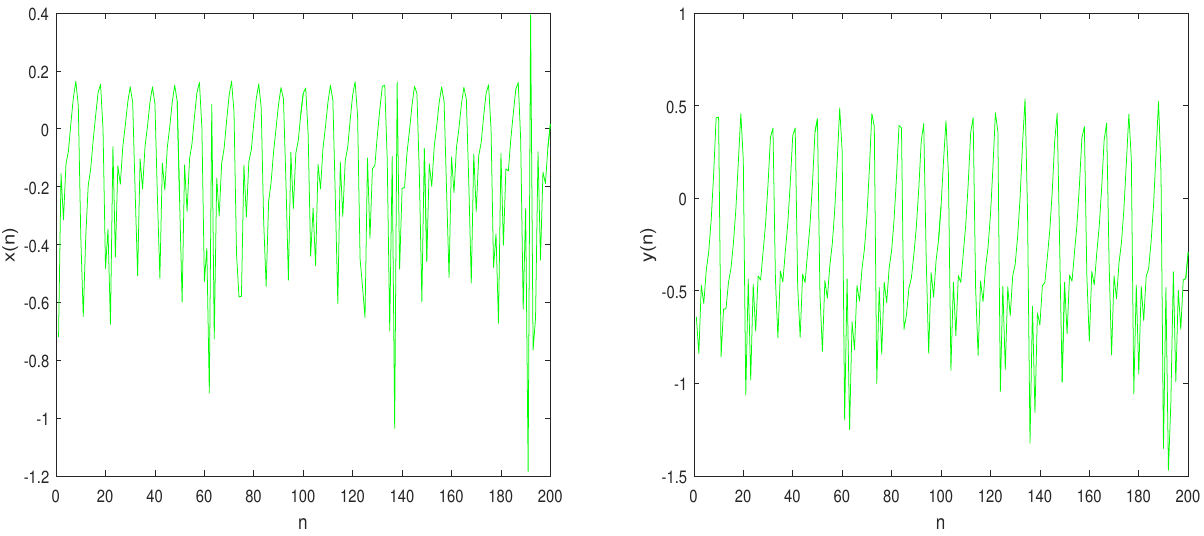
Figure 1. Time evolution of the system (8) states for the fractional variable-order µ ( r ) = 0.03 cos ( r /10 ) + 0.97.